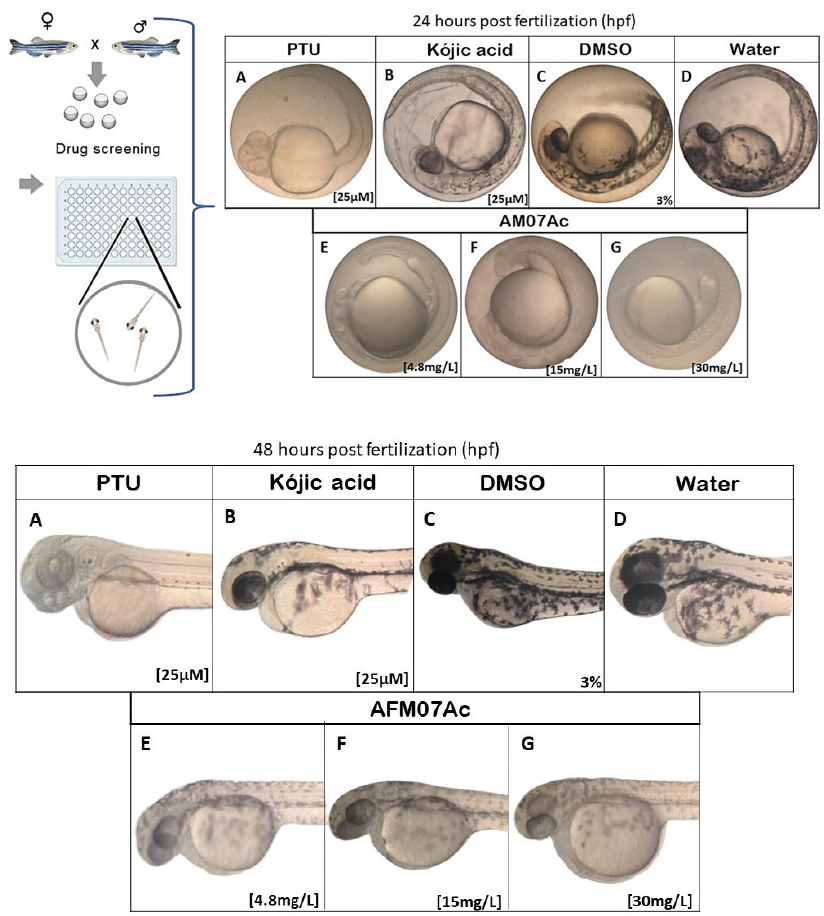
Figure 6. E ff ect of treatment with extract AM07Ac ( E – G ) on ZF embryos between 24 and 48 hpf. Embryos ( A – D ) were treated with positive and negative controls: ( A ) 0.25 µM PTU; ( B ) 0.25 µM kojic acid; ( C ) 3% DMSO; and ( D ) water.